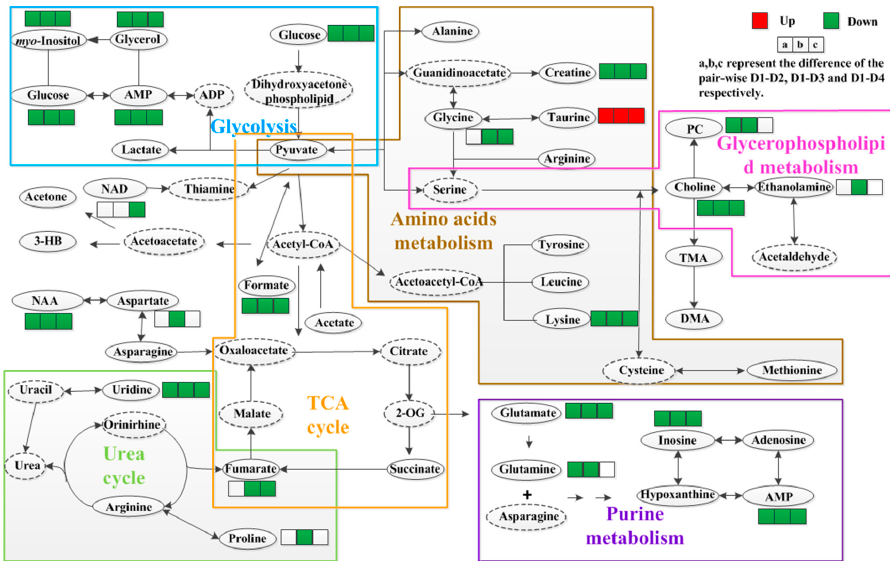
Figure 5. Metabolic pathways affected by dietary taurine in grouper intestinal extracts. Metabolites with a solid oval box were the identified metabolites in the grouper intestinal samples, and those with dashed ellipses were the possible intermediates in metabolic process.